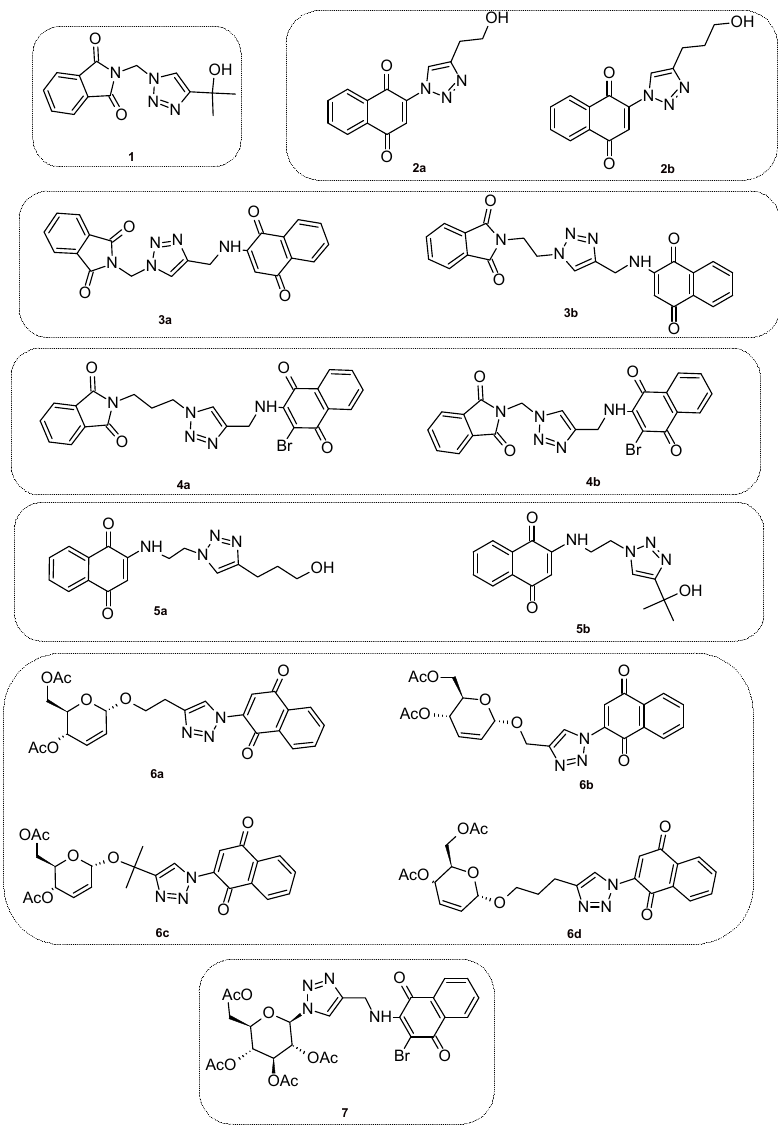
Figure 1. Strategy for molecular diversity towards antiviral 1 H -1,2,3-triazoles.